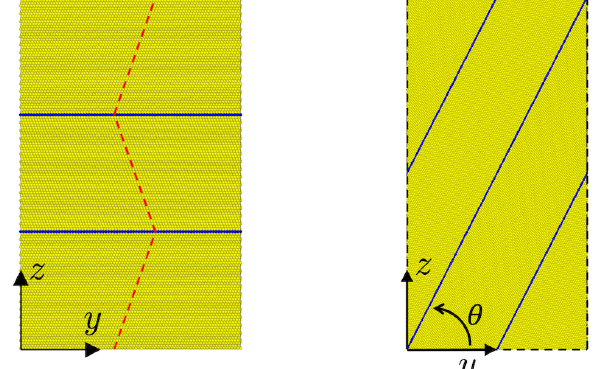
Figure 1. Simulation cells used to study deformation mechanisms and stress behavior in the presence of twinning. ( Left ) cell employed for comparison with the untwinned case. ( Right ) cell employed for variable twin boundary orientation. Visualization based on common neighbor analysis. Yellow: lattice (fcc). Blue: twin boundary (hcp). See text for